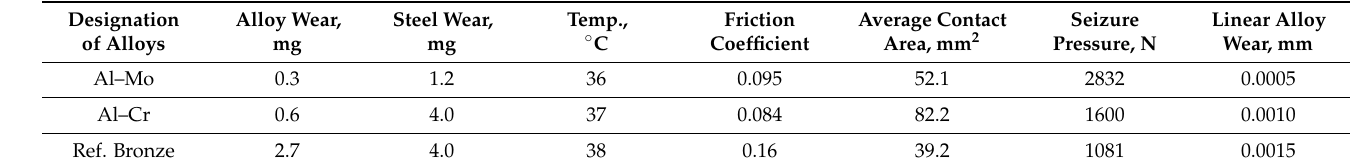
Table 8. Tribological test